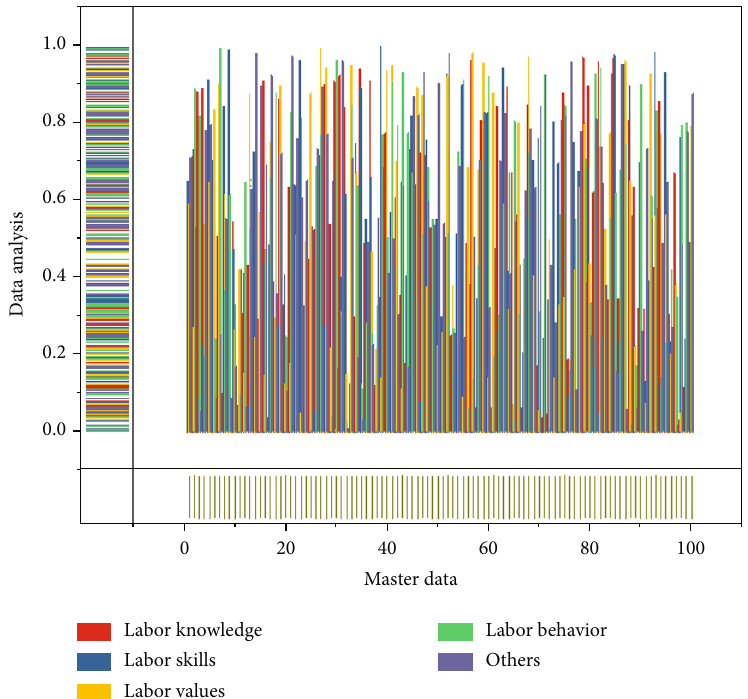
Figure 6: Analysis of the primary data of labor education.